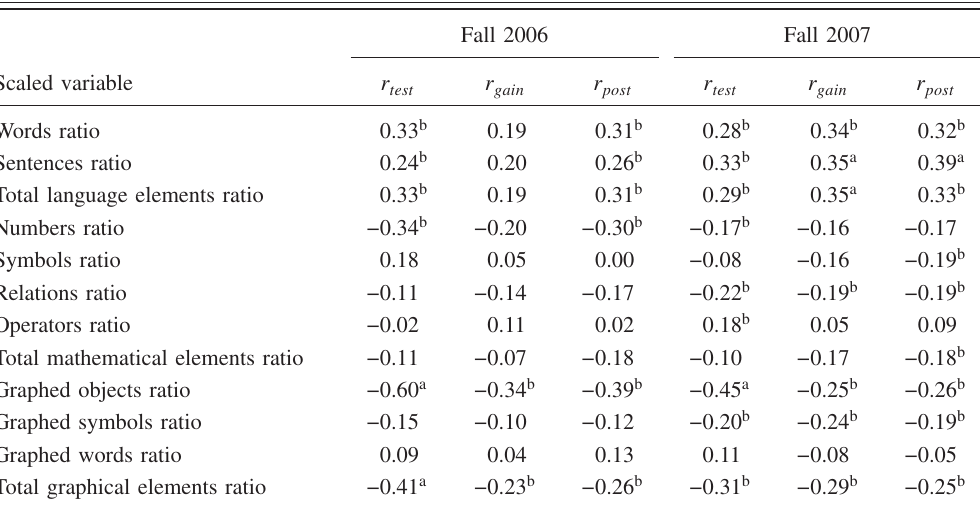
a Correlation with p (cid:7) 0.0001. b Correlation with p (cid:7) 0.05.